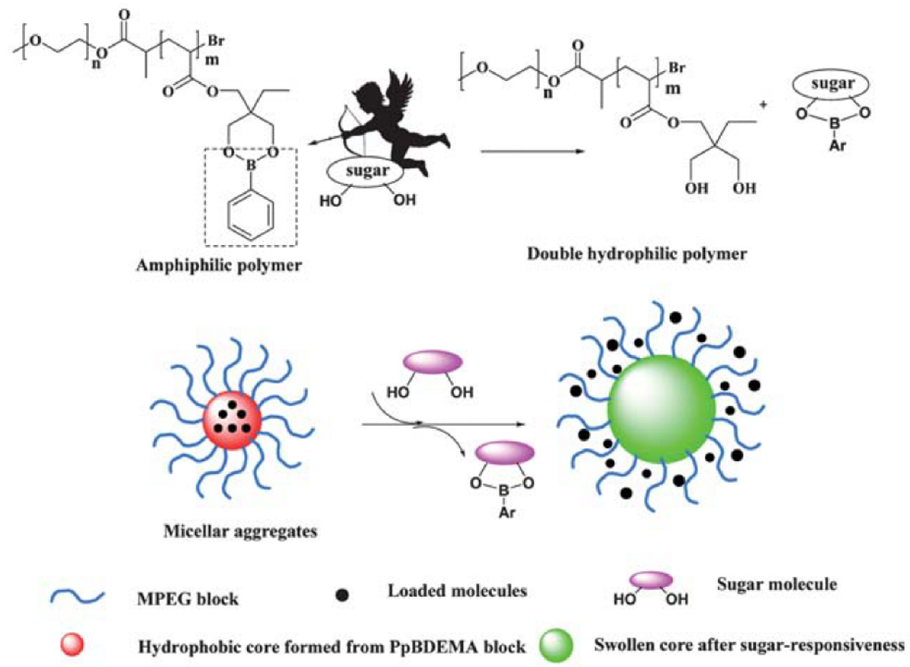
Figure 3: Schematic illustration for sugar-responsive behavior of nanoassembly. Reproduced with permission from [27]. Copyright 2011, The Royal Society of